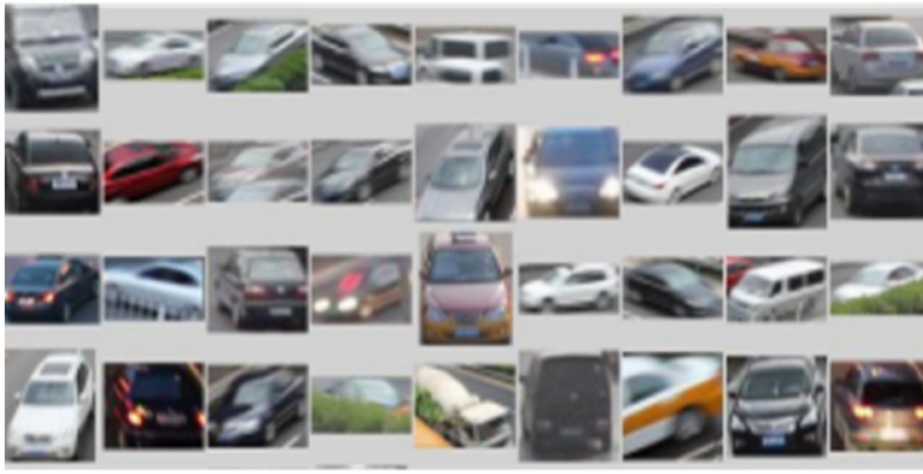
Figure 24. Depicts the sample images of VRIC dataset.